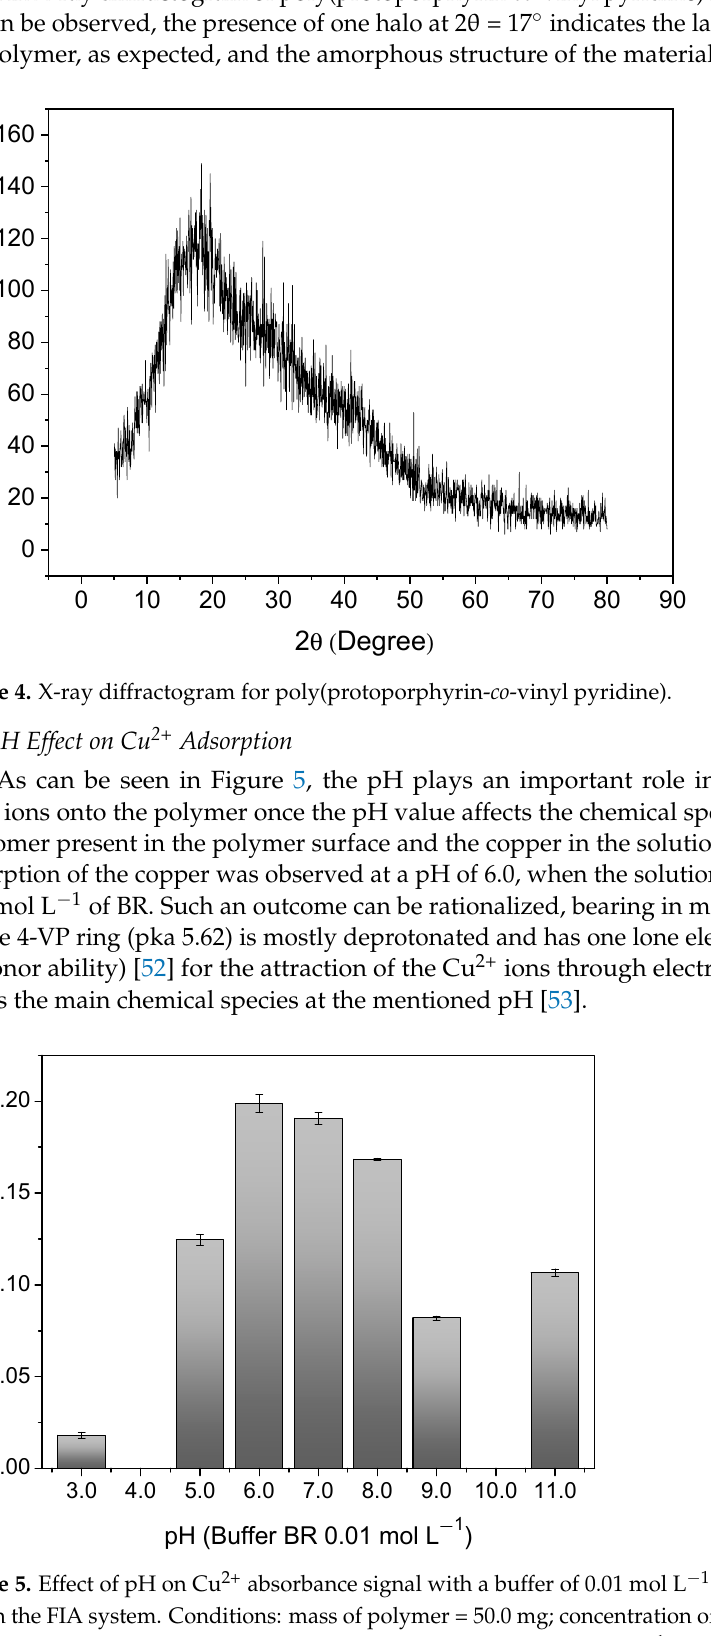
Figure 3. SEM micro-photographs of poly(protoporphyrin -co- vinyl pyridine) at ( a ) 25, ( b ) 400, ( c ) 800, ( d ) 1600, and ( e ) 6000 times magnified with a scale of 2.0 mm, 100.0 µm, 50.0 µm, 20.0 µm, and 10.0 µm, respectively.